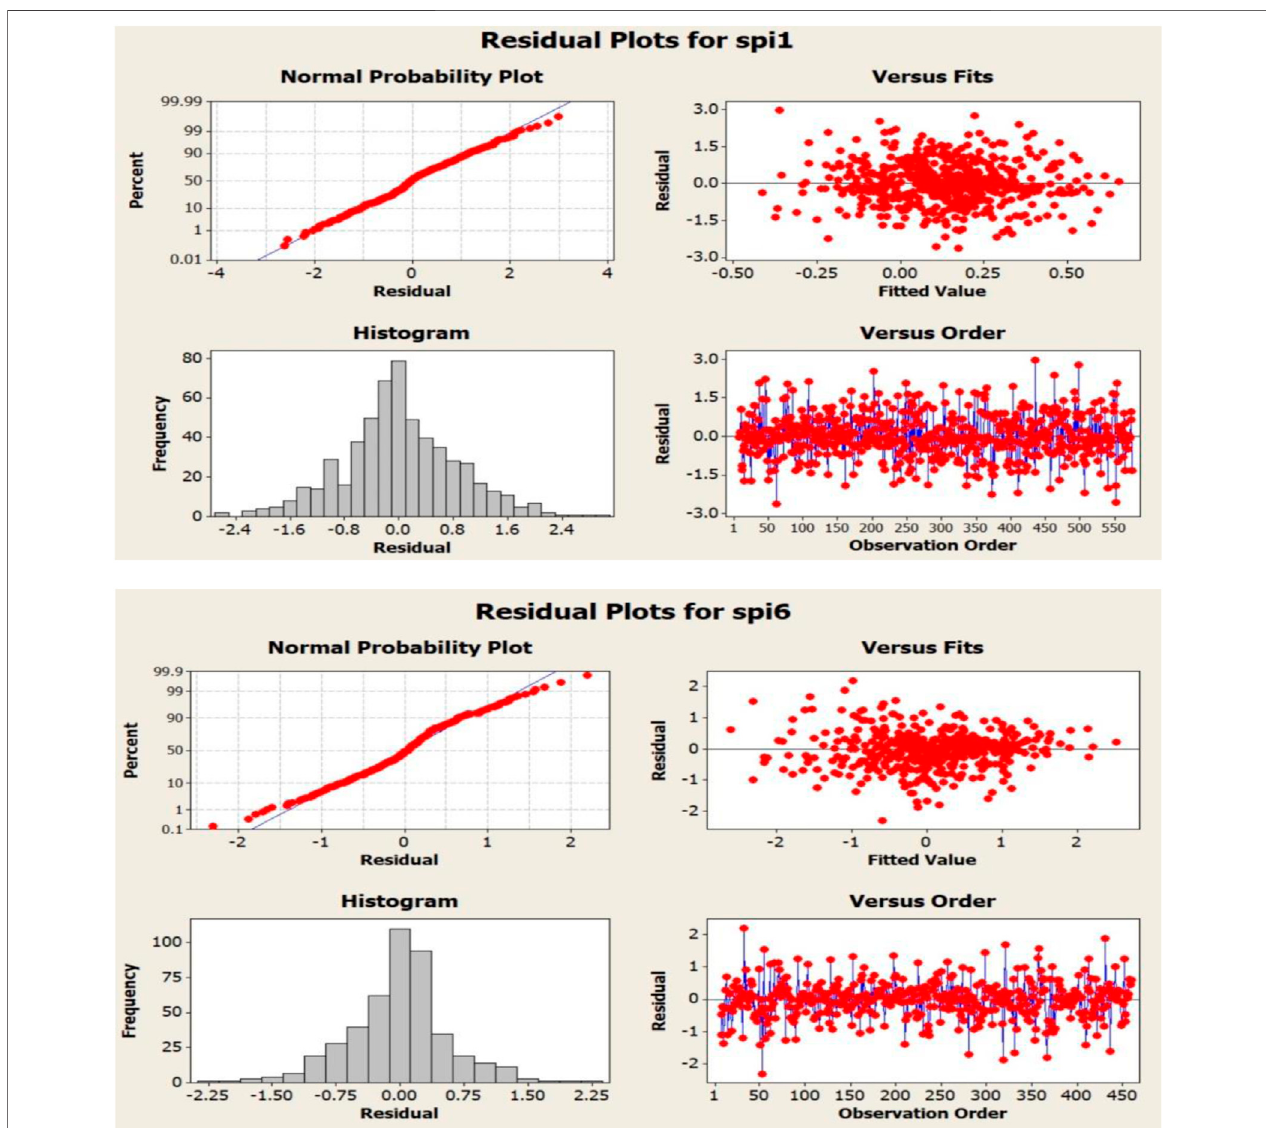
FIGURE 7 | Analysis diagrams of the residual of the selected model for one- and six-month drought index time series.